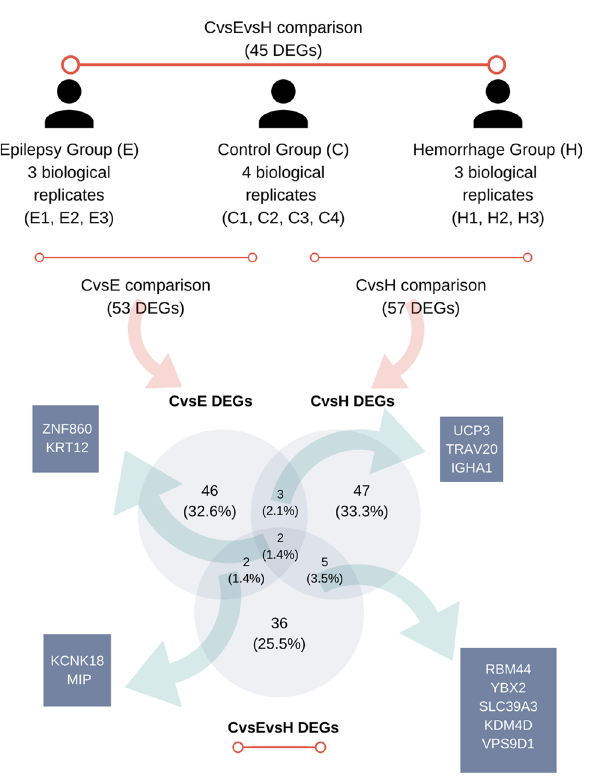
Figure 2. Description of sample groups (E, H, and C) and Venn diagram for common genes between CvsE (control vs epilepsy), CvsH (control vs hemorrhage), and CvsEvsH (control vs epilepsy vs hemorrhage) DEG (differentially expressed gene)